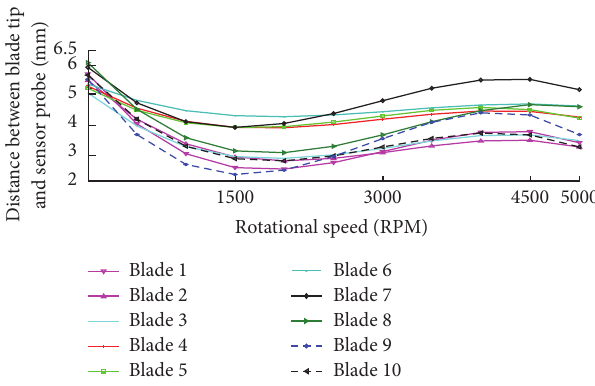
Figure 16: The tip clearance of each blade with rotational speed